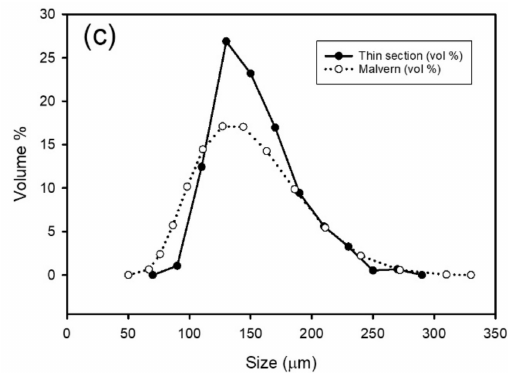
Figure 4. Grain size distribution from SEM images ( a ) superheavy fraction; ( b ) heavy fraction; ( c ) ilmenite fraction with a comparison obtained by using a Malvern particle size